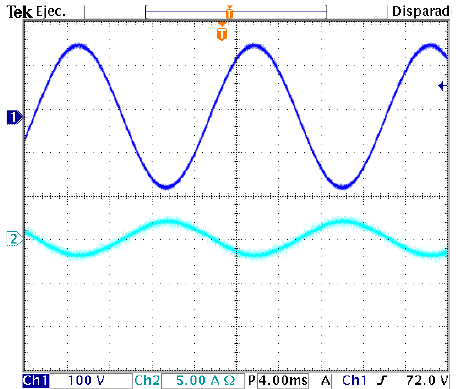
Figure 18. Voltage grid and current injected waveforms when the ESS is discharged.